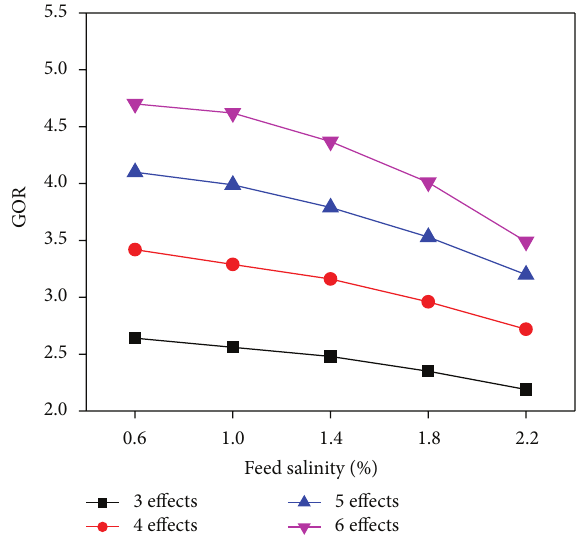
Figure 6: Variation of GOR with feed salinity.